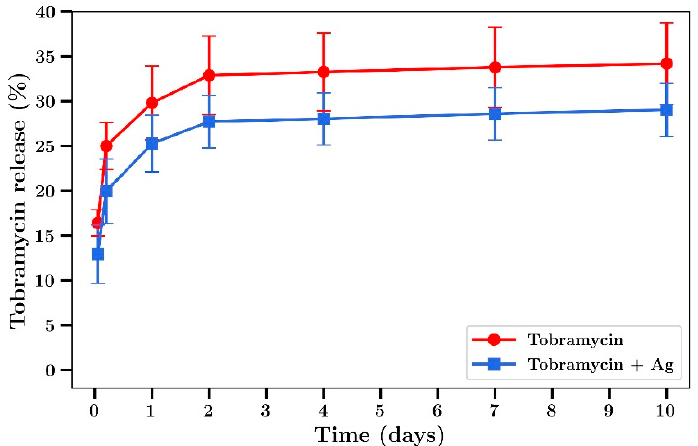
Figure 11. Time course of release of tobramycin from bone cement films containing tobramycin alone or tobramycin plus Ag. (Silver loaded at 0.8% and tobramycin at 0.8% w/w ) ( n = 4).